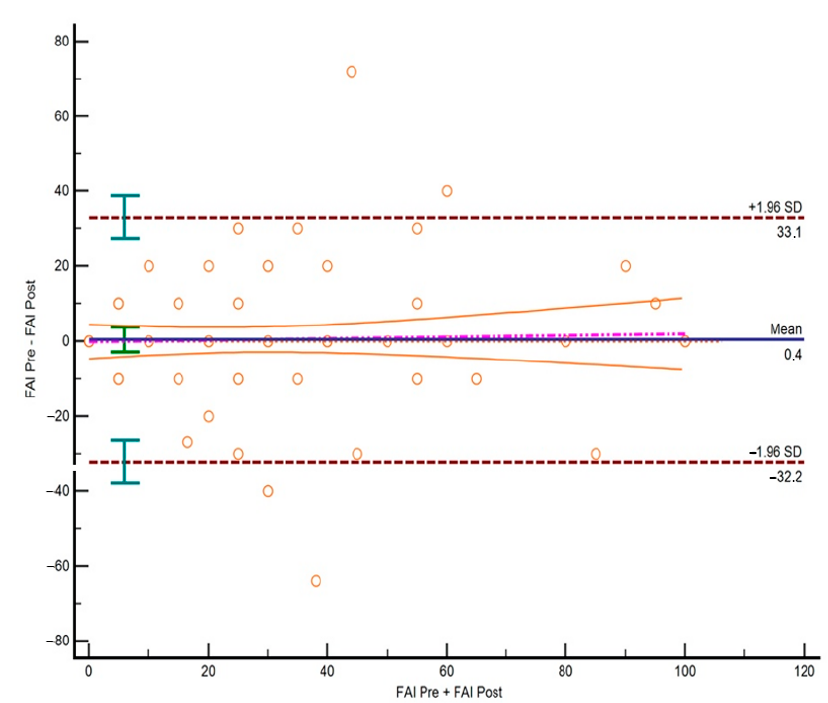
Figure 3. Bland–Altman plot.